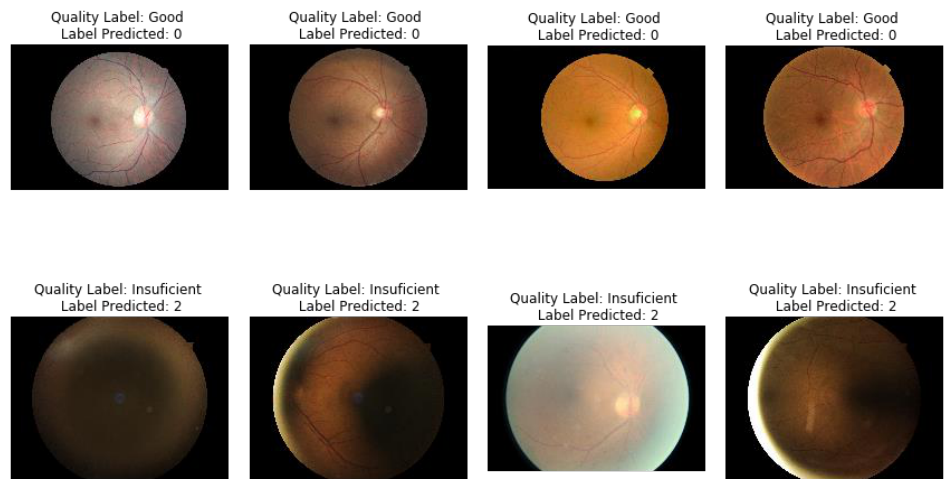
Figure 13. Receiver-operating characteristic curve for LoGit classification performance on validation